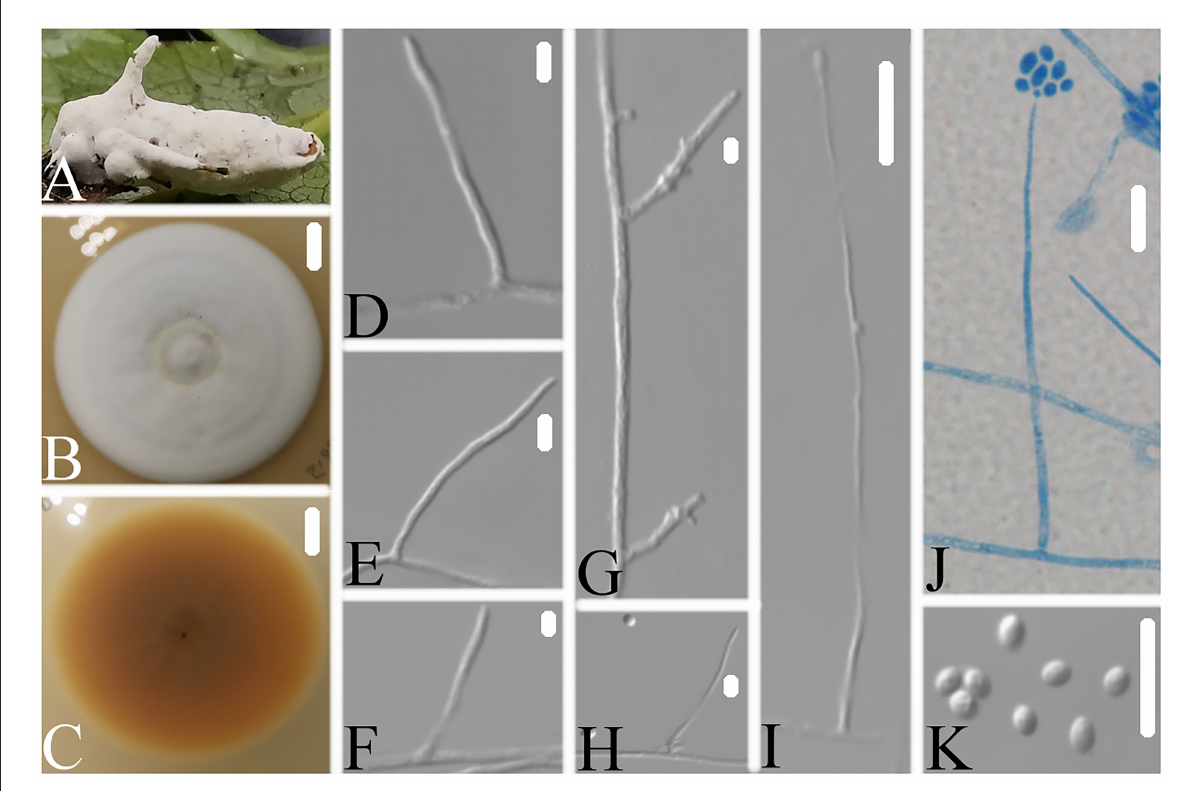
FIGURE5 Simplicillium coleopterorum (A) Infected insect (Coleoptera); (B,C) PDA-containing culture plate showing the front (B) and reverse (C) sides of the colony; (D–K) solitary phialides and conidia. Scale bars: 10mm (B,C) and 10 µ m (D–K)